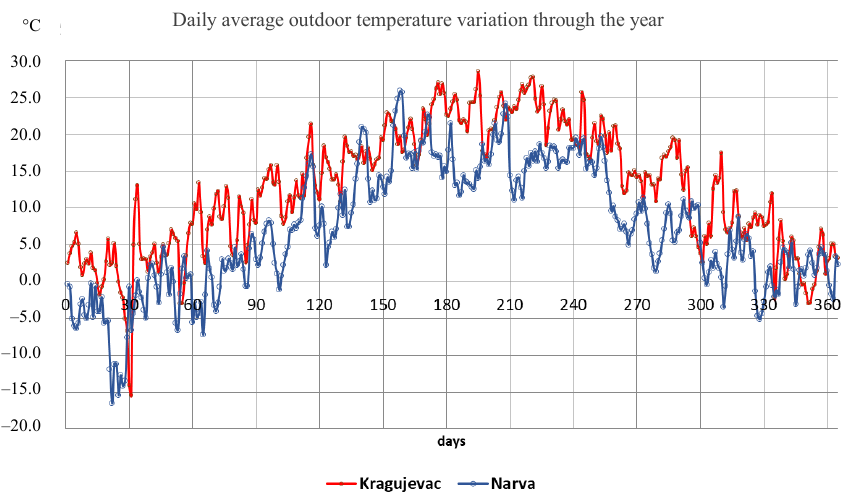
Fig. 1. Average daily outdoor temperatures for Narva and Kragujevac .